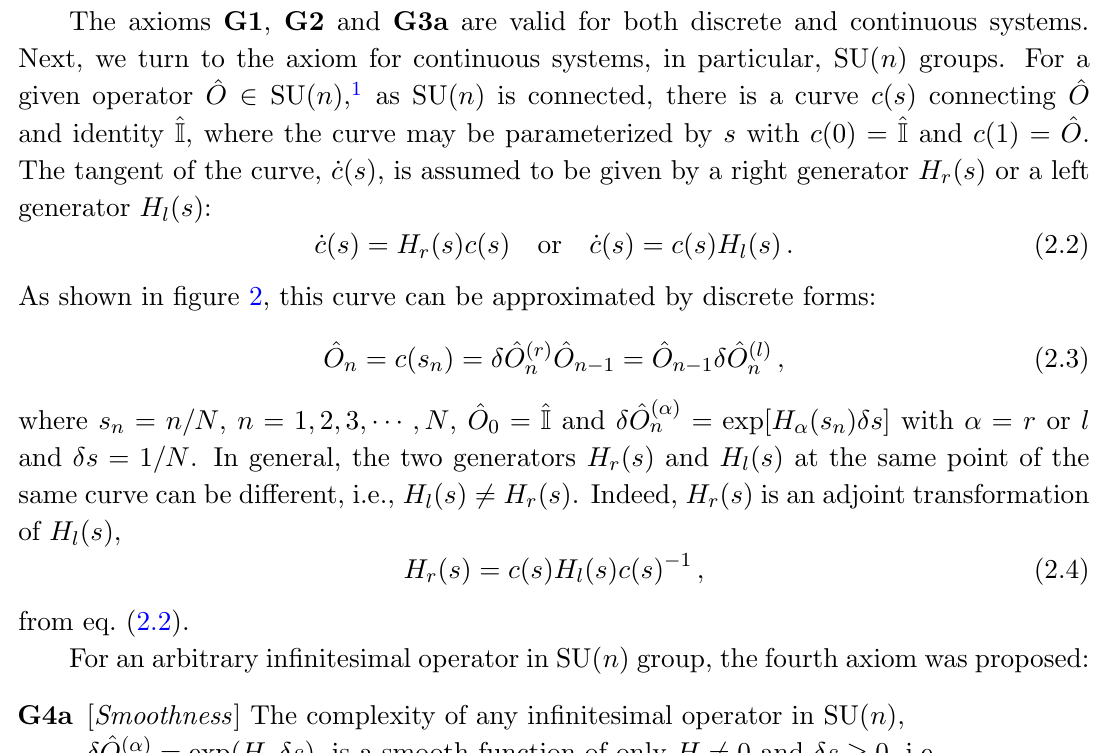
Figure 1 . Schematic diagram for G3a in quantum circuits. Two operators ^ x 1 and ^ x 2 are indepen- dent so it is natural that C ((^ x 1 ; ^ x 2 )) = C ((^ x 1 ; ^ I 2 )) + C ((^ I 1 ; ^ x 2 )). The axioms G1 , G2 and G3a are valid for both discrete and continuous